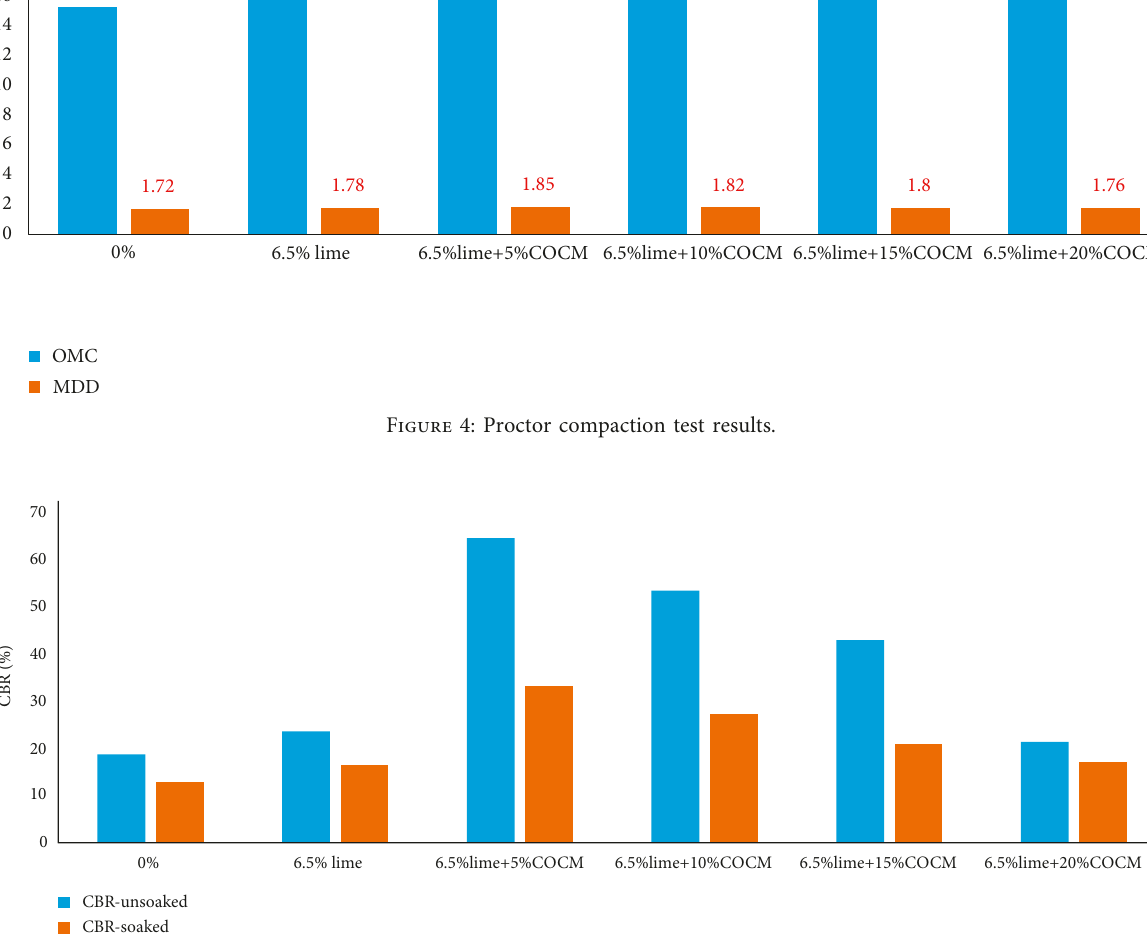
Figure 5: CBR test results.